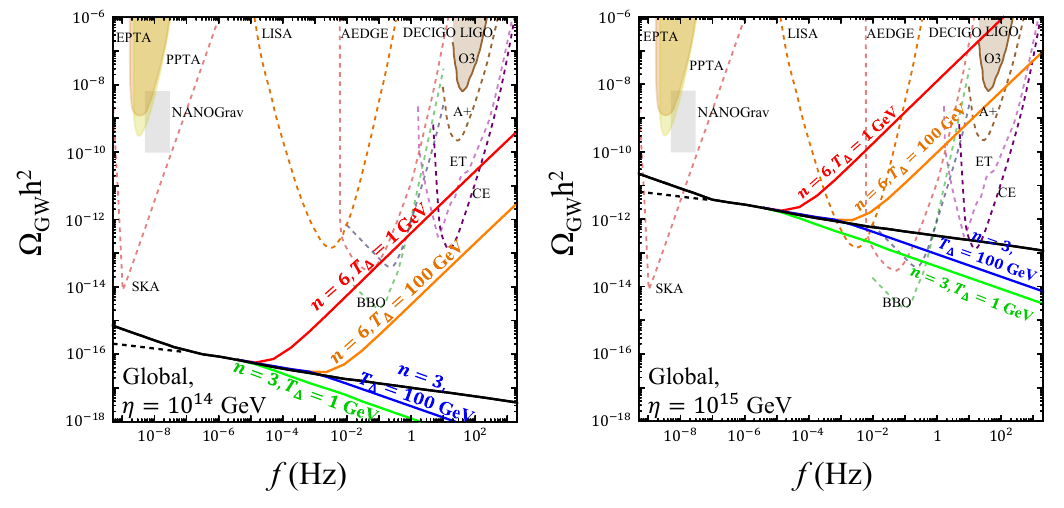
Figure 9 . Gravitational wave spectrum from a global cosmic string network with α = 0 . 1 , F α = 0 . 1 for η = 10 14 (left) and 10 15 GeV (right). The solid black lines show the GW spectrum with the standard cosmological evolution. The colored lines show the results with an EMD ( n = 3 ) or kination ( n = 6 ) that ends and restores the late RD era at the temperature T 10 2 GeV. The sensitivities of related GW experiments are also